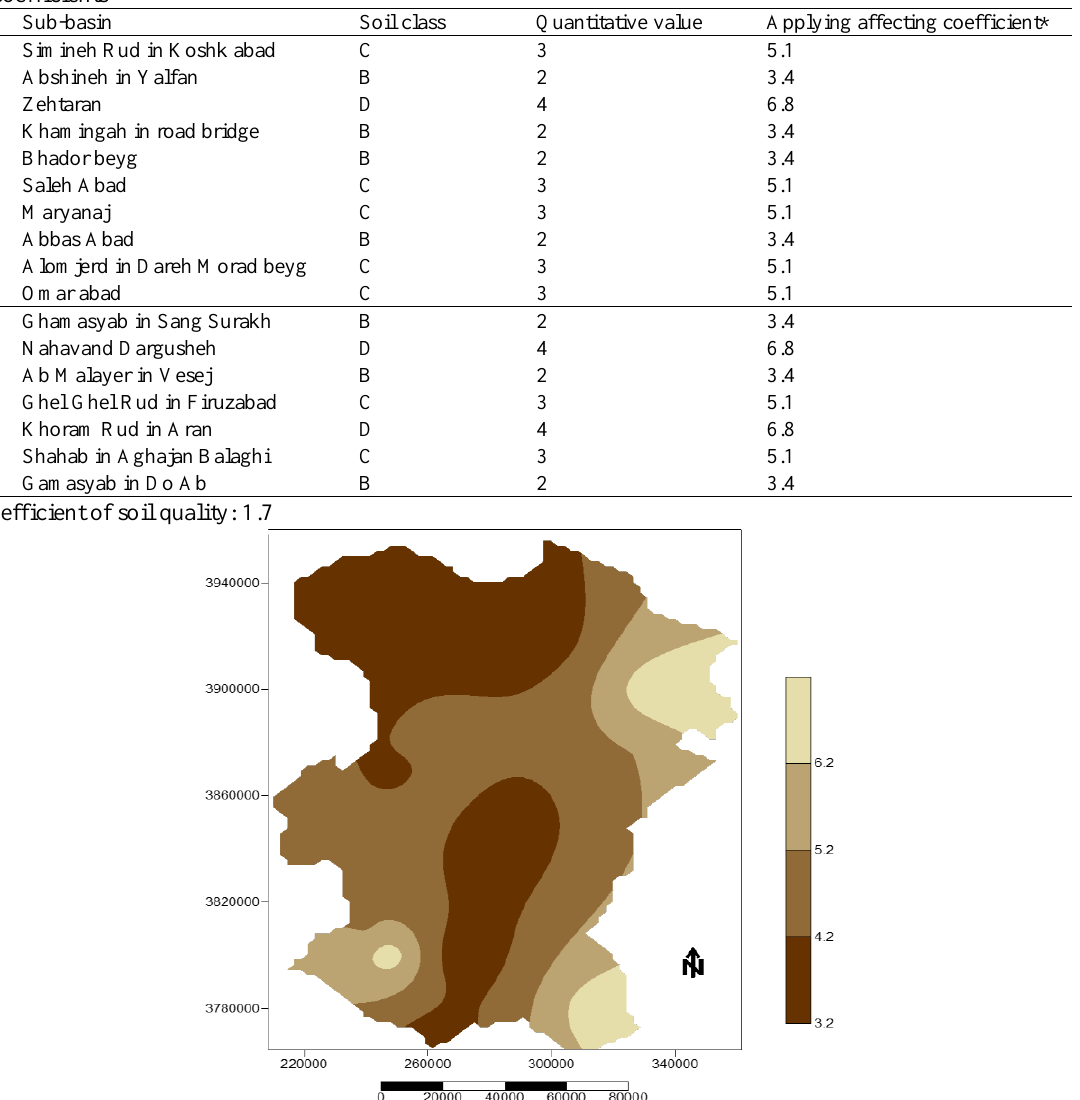
Fig. 6. Zoning of soil quality of Gamasyab and Gharechay